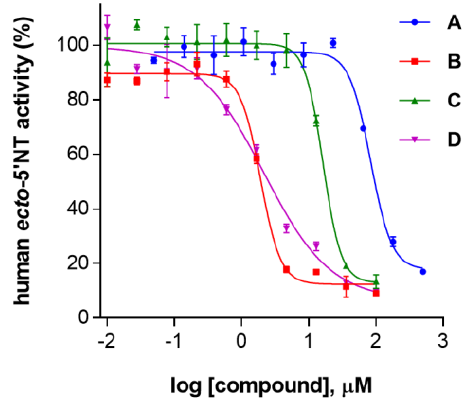
Figure 2. Dose-response curves for each tested compound ( A , B , C and D ). All assays were carried out in a reaction mixture containing HEPES buffer (10 mM; pH = 7.4), MgCl 2 (2 mM), CaCl 2 (1 mM), human ecto -5 (cid:48) -NT (3.6 nM), AMP (500 µ M) as substrate, and each tested compound over a range of concentration values (0–500 µ M for A and 0–100 µ M for B , C and D ). The concentration of DMSO in all samples was kept at 1.0% ( v / v ). After incubation for 10 min at 37.0 ± 0.2 ◦ C, the reactions were stopped by heating the system for 5 min at 99.0 ± 0.2 ◦ C. Inorganic phosphate released in the reaction was quantified spectrophotometrically (at λ = 630 nm), using the malachite green method, as described in the literature [56]. Data are expressed as the percentage of human ecto -5 (cid:48) -NT activity. Each experiment was done in triplicate. A four-parameter logistic non-linear regression model was used to fit the experimental data, using GraphPad Prism (GraphPad, San Diego, CA,